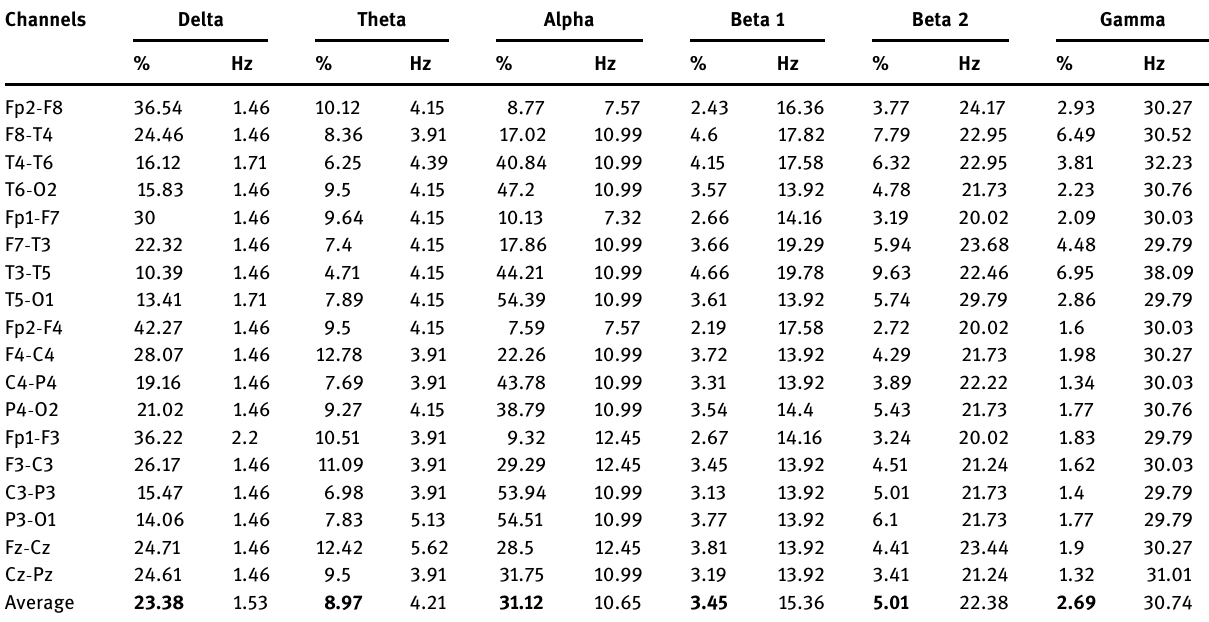
Table 1: Pre: Amplitude of each channel of subject 1 Channels